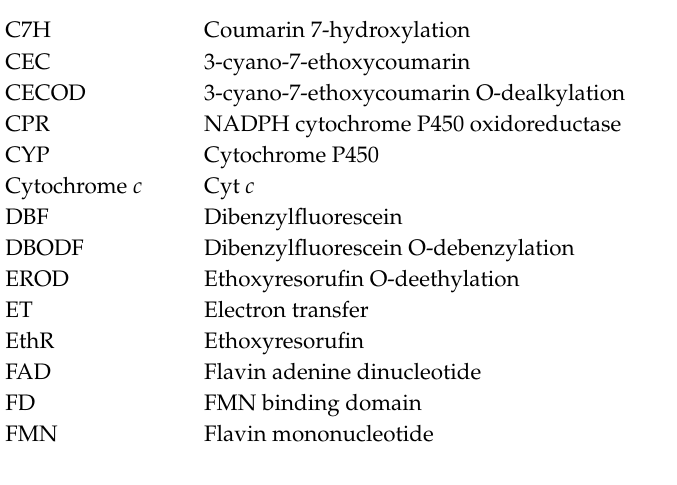
s1. Table S1: Kinetic steady-state parameters of CYP1A2, 2A6 and 3A4-activities; Table S2: Kinetic steady-state parameters of CYP1A2-activities with CEC and DBF; Table S3: Summary of determinant CPR residues directly involved in hydrogen bonds / salt bridges on both FD:cyt c and FD:CYP binding sites; Figure S1: Protein sequence the human CPR FD; Figure S2: Relative turnover rates ( k cat) (x fold) of the CPRmut:CYP1A2 MROD activities (using 0–2 µ M MthR), normalized by the k cat demonstrated by CPRwt / CYP (determined in membrane fractions) (technical replicates N = 3); Figure S3: Structural models of the FD binding site of rat CPR; Figure S4: RMSD of the 80 ns simulations; Figure S5: Comparison of the deviations between each average structure obtained from simulation and the FMN domain from the crystal structure of human CPR (PDB 5FA6); Figure S6: Hydrogen bonds between H117 and D116 or E118 in the P117H mutant; Figure S7: Acidic residues surrounding the aspartate 151 in the N151 D mutant; Figure S8: Variation of pKa of the surrounding charged residues for G144C mutant; Figure S9: Distances between the OH atom of Y143 or Y181, N atom of C144 or G144, CG2 atom of V191 and either the C7M, C8M, N3 or N5 atoms of FMN in WT or G144C mutant; Figure S10: Analyses of the various ϕ and ψ angles for β -strands 3 and 4; Figure S11: Analysis of the ϕ angles along the four simulations for residues 175 and 141 in the WT and G175 FD mutant; Figure S12: Distances between the OH atom of Y143 or Y181, N atom of C144 or G144, CG2 atom of V191 and either the C7M, C8M, N3 or N5 atoms of FMN in WT or G175D